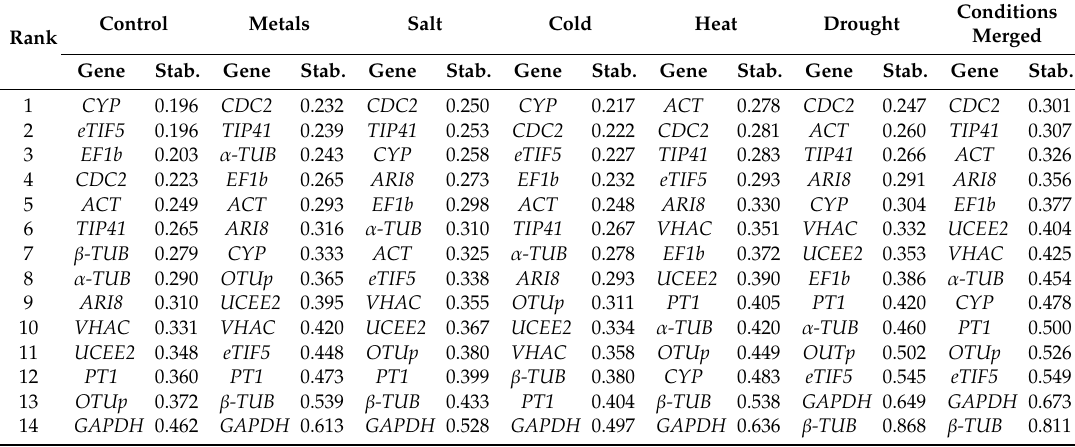
Table 3. Potential reference genes (RGs) to normalize qPCR data in Salix viminalis roots exposed to various abiotic stresses. Plants were exposed to the stresses for up to two months. RGs expression stability is given by the “Average expression stability M” value as determined by geNorm PLUS . Lower stability value means greater stability. Stab.: gene stability